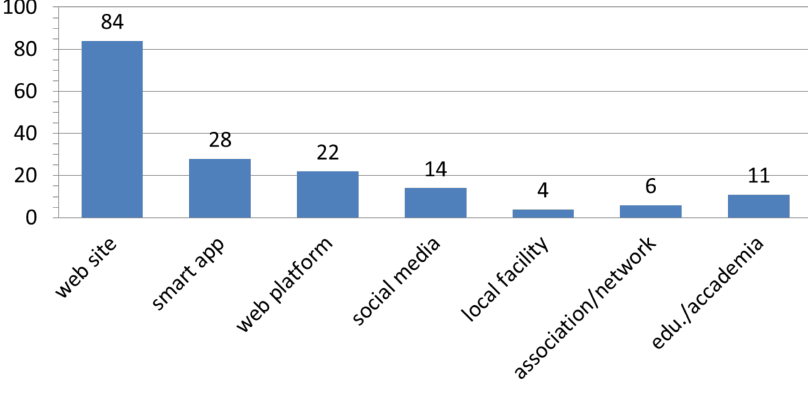
Figure 3. Summary of the results relative to the recruitment approaches.